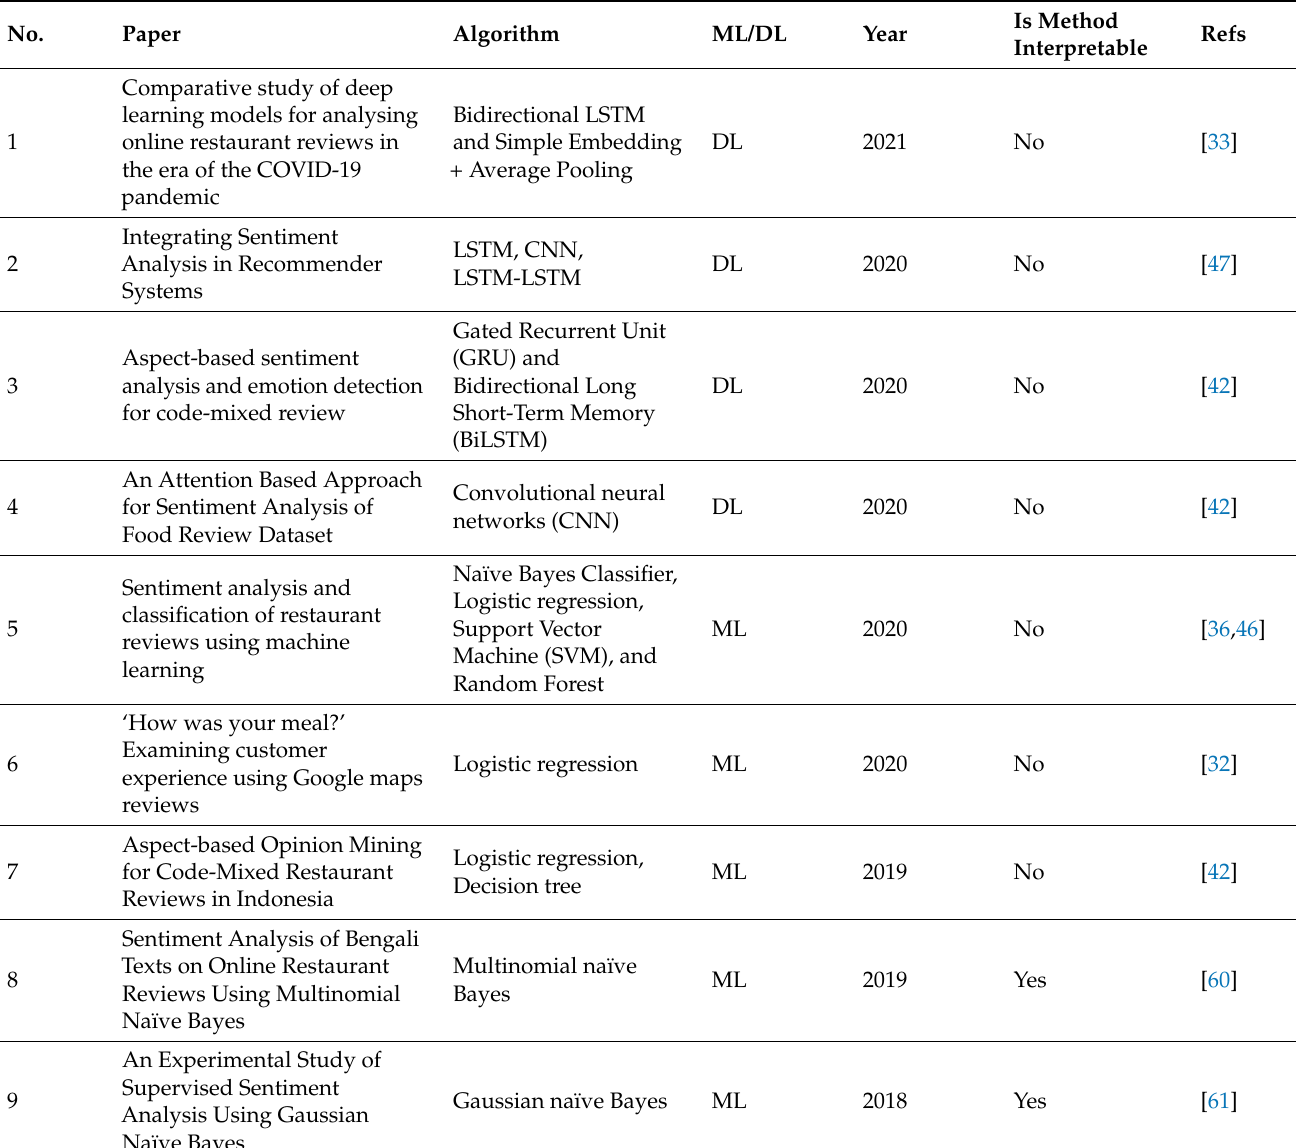
Table 5. Interpretability of methods used for sentiment analysis in